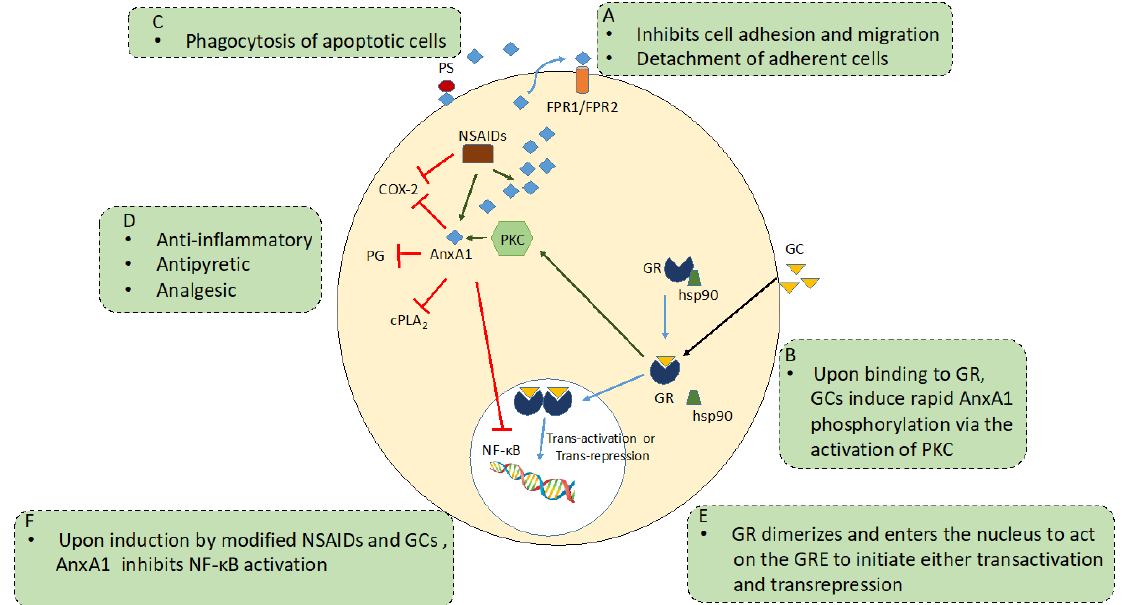
Figure 2. The principal mechanisms of AnxA1 anti-inflammatory actions. ( A ) Exogenous AnxA1 binds to formyl peptide receptors (FPR) to inhibit cell adhesion, migration and induce detachment of adherent cells [108]. ( B ) AnxA1 expression and release is up-regulated with GC treatment through the GC receptor (GR) either through genomic or non-genomic mechanisms, which contributes to the anti-inflammatory effects of AnxA1. GCs induce rapid AnxA1 phosphorylation via the activation of PKC and initiate the membrane translocation of AnxA1 molecule [72]. ( C ) AnxA1 is recruited to the cell surface, where it binds to phosphatidylserine (PS) and mediates the phagocytosis of apoptotic bodies [109]. ( D ) AnxA1